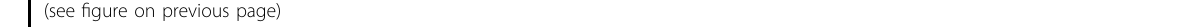
Fig. 4 MIRLET7BHG sponged miR-330-5p to upregulate SMO. A RNA pull-down assay examined the enrichment of miR-326 and miR-330-5p by biotin-labeled SMO. B qRT-PCR examined the overexpression ef fi ciency of miR-330-5p in activated HSCs. C qRT-PCR revealed the in fl uence of upregulated miR-330-5p on SMO expression in activated HSCs. D Binding sites between SMO and miR-330-5p were predicted by starBase database. E Luciferase reporter assay examined the changes in luciferase activity of wild-type and mutant SMO in activated HSCs after overexpressing miR-330- 5p. F RNA pull-down assay revealed the enrichment of four potential lncRNAs by biotin-labeled miR-330-5p. G qRT-PCR determined MIRLET7BHG expression in quiescent and activated HSCs. H qRT-PCR validated the depletion ef fi ciency of MIRLET7BHG and also evaluated the in fl uence of silenced MIRLET7BHG on SMO expression in activated HSCs. I LncLocator database and subcellular fraction assay revealed the subcellular location of MIRLET7BHG in activated HSCs. J Binding sites between MIRLET7BHG and miR-330-5p were predicted by starBase database. K RNA pull-down assay revealed the enrichment of MIRLET7BHG pulled down by biotin-labeled miR-330-5p. L RIP assay analyzed the enrichment of MIRLET7BHG, miR-330- 5p, and SMO in anti-Ago2 group relative to anti-IgG group. M Luciferase reporter assay detected the changes in luciferase activity of wild-type and mutant MIRLET7BHG under miR-330-5p overexpression. ** P < 0.01, “ n.s ” represents no signi fi